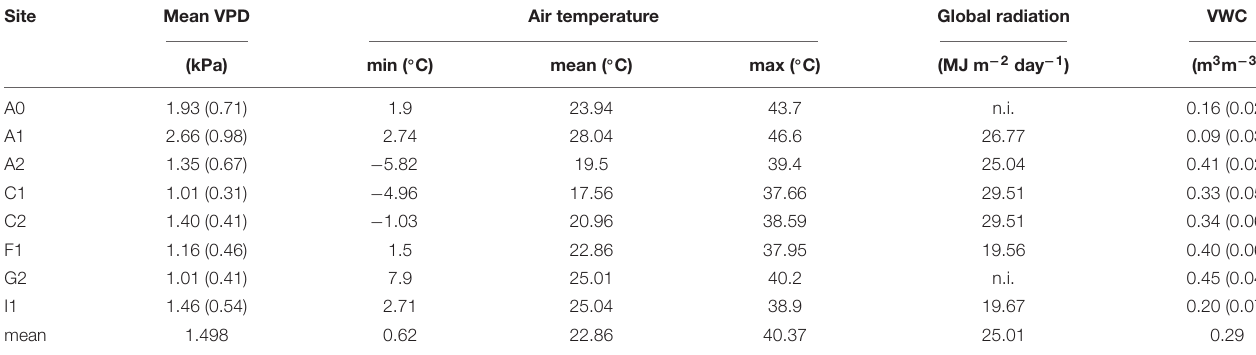
TABLE 2 | Main climatic parameters at each site during the growing season (May to August or November to February). Site Mean VPD Air temperature Global radiation VWC